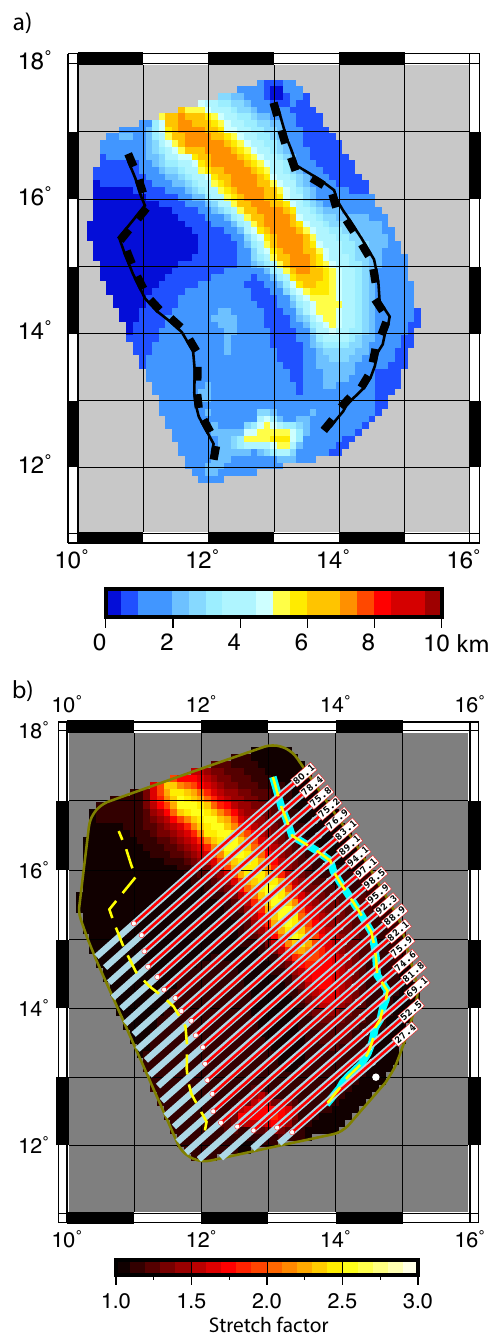
Fig. 3. Computed extension for the Termit Basin in Chad based on total sediment thickness. (a) sediment thickness based on Exxon Production Research Company (1985); (b) stretching factor grid and computed amount of extension using the method of Le Pi- chon and Sibuet (1981) – see text for details. Estimates of hori- zontal extension for the Termit Basin. Cyan-coloured lines are main rift bounding faults, light-blue lines are profile lines with original length, red lines are restored length based on extension estimates from sediment thickness. Numbers indicate individual amount of computed extension along each line in